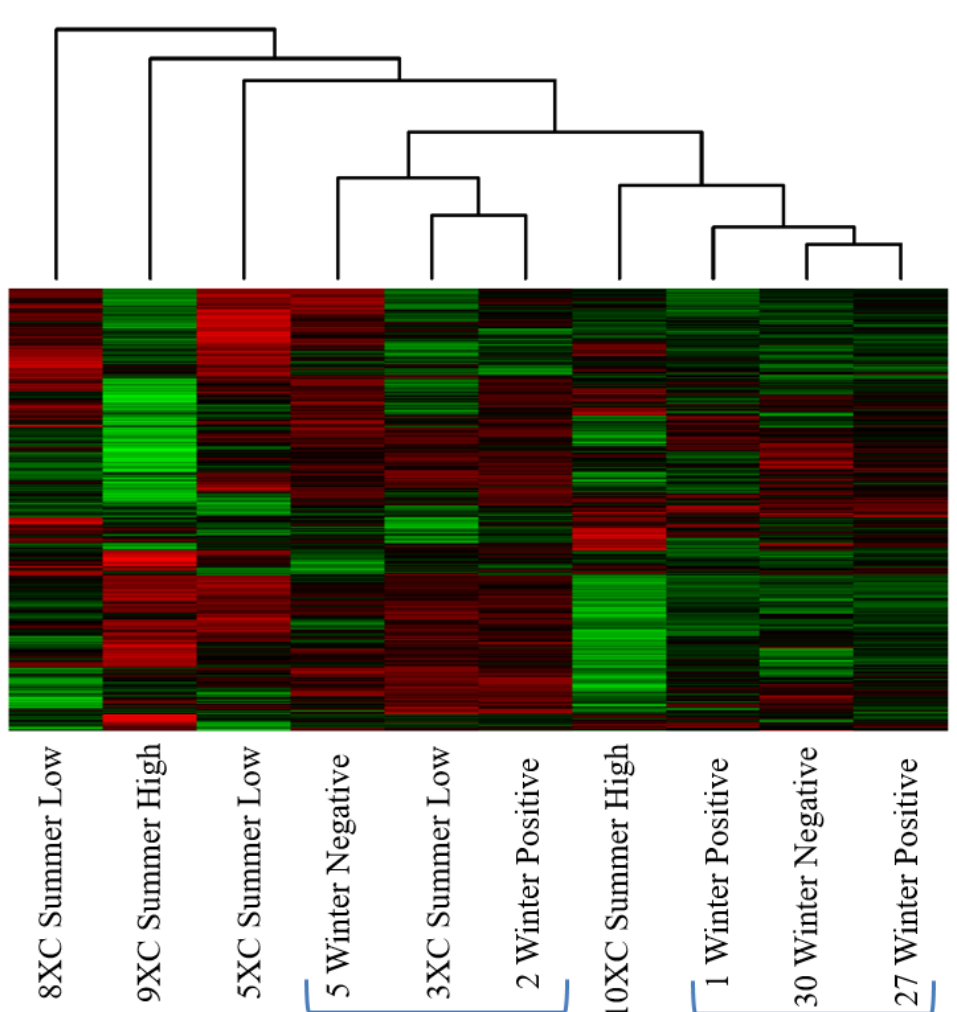
Figure 4. Heatmap and clustering analysis of summer cattle that had either high or low concentrations of Salmonella in the sub-iliac lymph nodes, and winter cattle, that were positive or negative for Salmonella in the sub-iliac lymph node. Clusters are based on the relative similarity of the kinome profiles. The two clusters of winter cattle and the interspersed and outlier summer cattle indicate a varied kinome in the summer animals. Each column represents a tissue sample; each row is a peptide. Red represents relative increase in phosphorylation and green relative decrease.